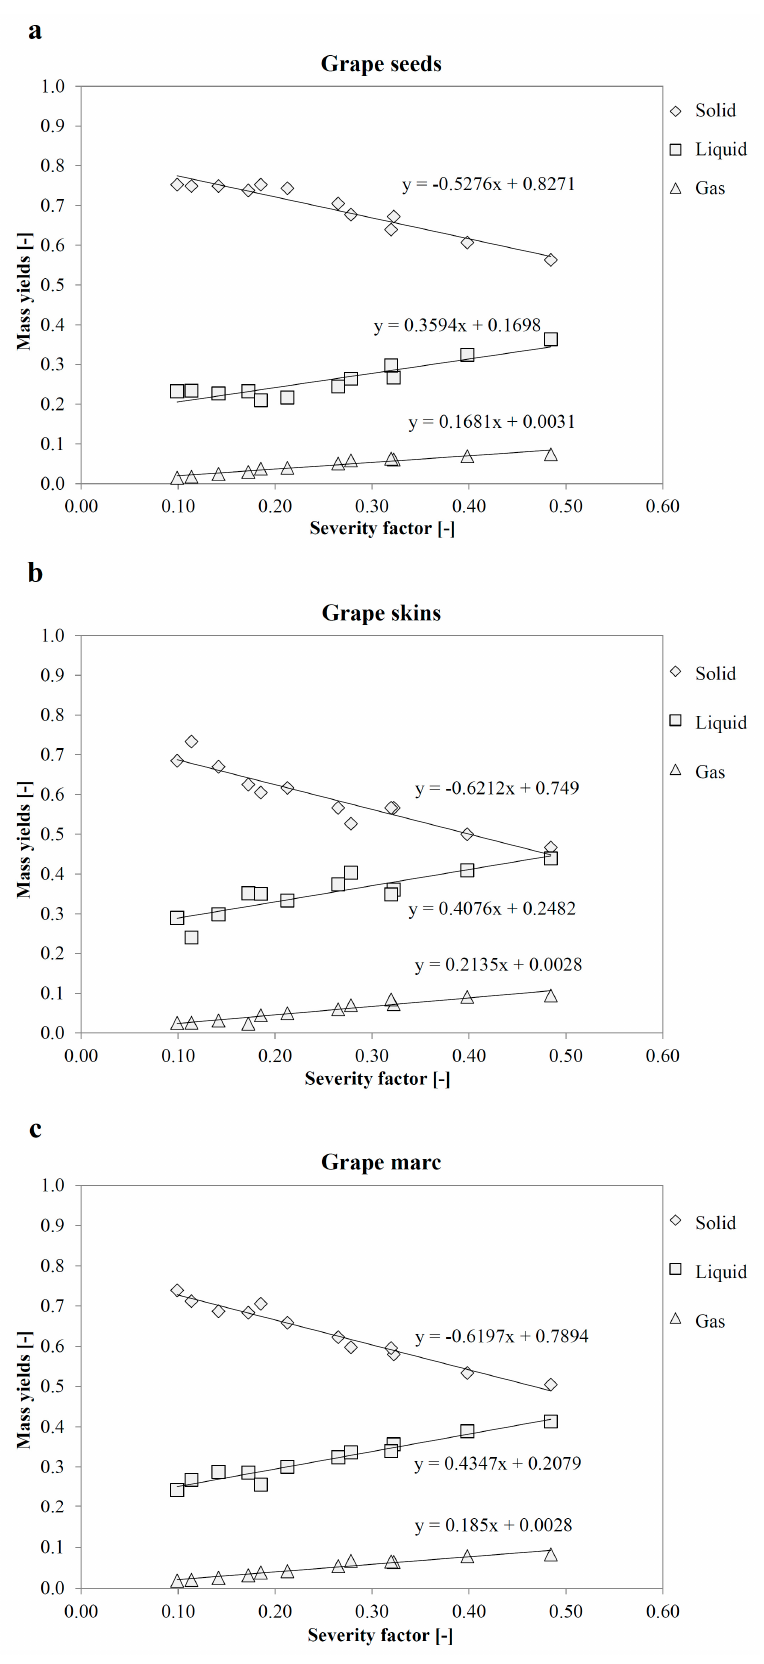
Figure 6. Mass yields of grape seeds ( a ), skins ( b ), mar ( c ) vs severity factor (SF).